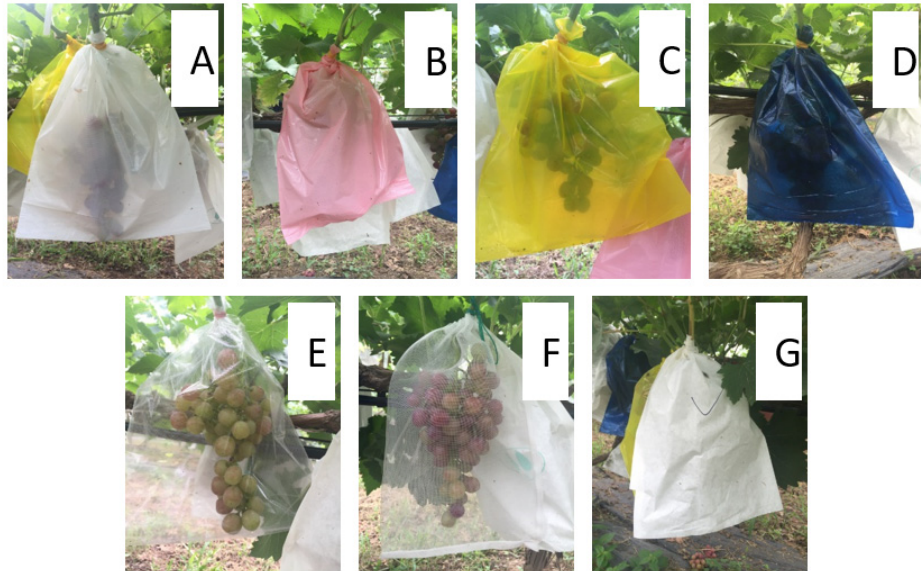
Figure 1. Fruit bagging treatment with different types of bags. ( A ): white polypropylene micro-perforation bags; ( B ): pink polypropylene micro-perforation bags; ( C ): yellow polypropylene micro-perforation bags; ( D ): blue polypropylene micro-perforation bags; ( E ): transparent polypropylene micro-perforation bags; ( F ): nylon mesh bags; and ( G ): white paper bags.